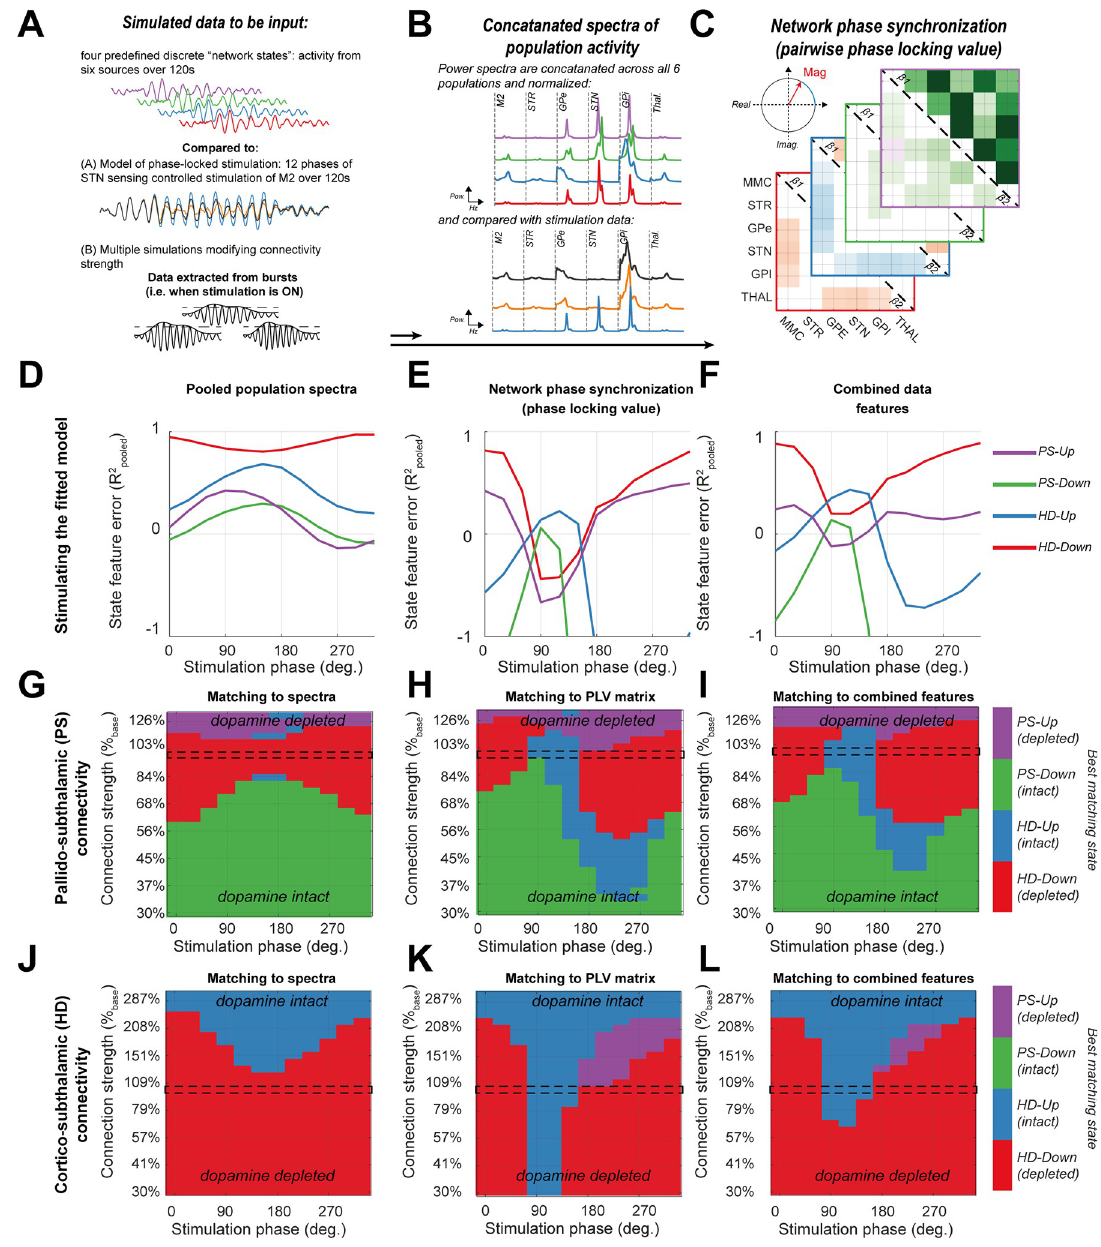
Fig 5. Stimulation of the cortex phase locked to activity sensed in the STN can induce network-wide patterns of activity that resembles those corresponding to spectral fingerprints of spontaneous activity associated with changes in connection strength. (A) Data simulated from the four network states PS-Up (purple), PS-Down (green), HD-Up (blue), and HD-Down (red) (see main text and Fig 2) was used to compute spectral fingerprints of spontaneous burst activity which were then compared against those constructed from the outcomes of phase locked stimulation. Only data during which stimulation was delivered (i.e., within a high amplitude STN beta burst event) was analysed. We used two different spectral fingerprints to compare network states with stimulated epochs: (B) the concatenated power spectra of each of the 6 populations in the CBGT circuit. Data were normalized to unit variance prior to concatenation such that comparisons were focused on the shape of spectra rather than large differences in amplitude. (C) Matrices of the pairwise phase synchronization (magnitude of the PLV) were estimated using the Hilbert transformed signals (see Fig 3A) for both β 1 and β 2 frequencies. (D, E, and F) Stimulation was applied across 12 phases in the fitted model and data were compared (using pooled R 2 ) to each network state using: the concatenated spectra (D); the matrix of PLV magnitudes (E); and the two features combined (F). These results show that spectral fingerprints from stimulation outcomes resembles that from different network states (i.e., a change in synaptic connectivity) depending upon the phase at which stimulation was delivered. (G, H, I) The above was repeated but when varying the connection strength of the PS pathway. Results are plot as a heatmap color-coded to indicate the best fitting state at each phase